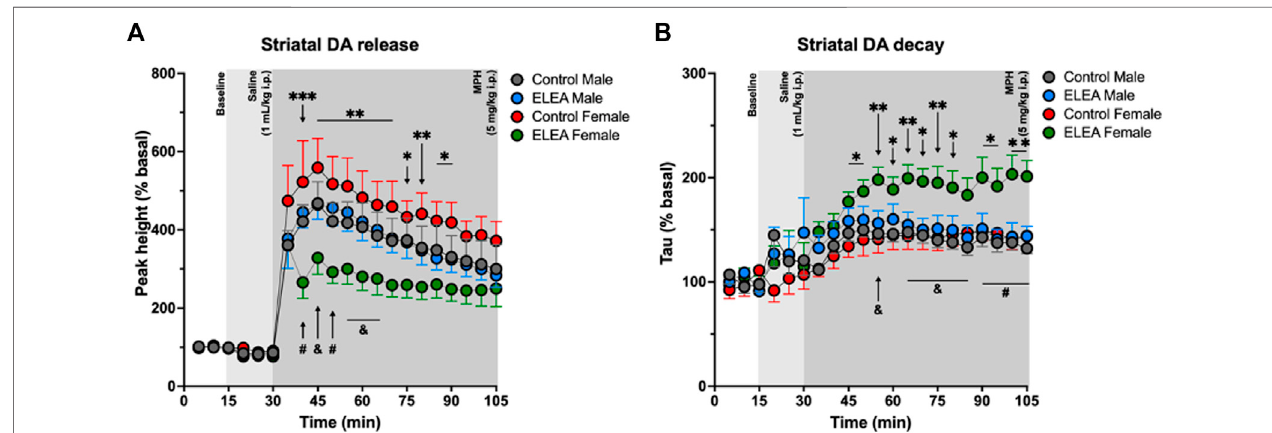
FIGURE 4 | Analysis of the dorsolateral striatal in-vivo dopamine release evoked by substantia nigra electrical stimulation. (A) Dopamine release regarding the baseline(%)forthepeakheight.ELEAfemalesreleaseloweramountofdopaminethancontrolfemalesandELEAmales,butantibioticexposuredidnotaffectDArelease inmales. (B) Striataldopaminedecay.ELEAfemalesshowedahigherdecay(Tau)thancontrolfemalesandELEAmales.(ELEAfemaleVs.controlfemale:***= p < 0.001; **= p < 0.01;*= p < 0.05.ELEAfemaleVs.ELEAmale:#= p < 0.01;and= p < 0.05;controlmale, n =6;ELEAmale, n =5;controlfemale, n =4;ELEAfemale, n =4).